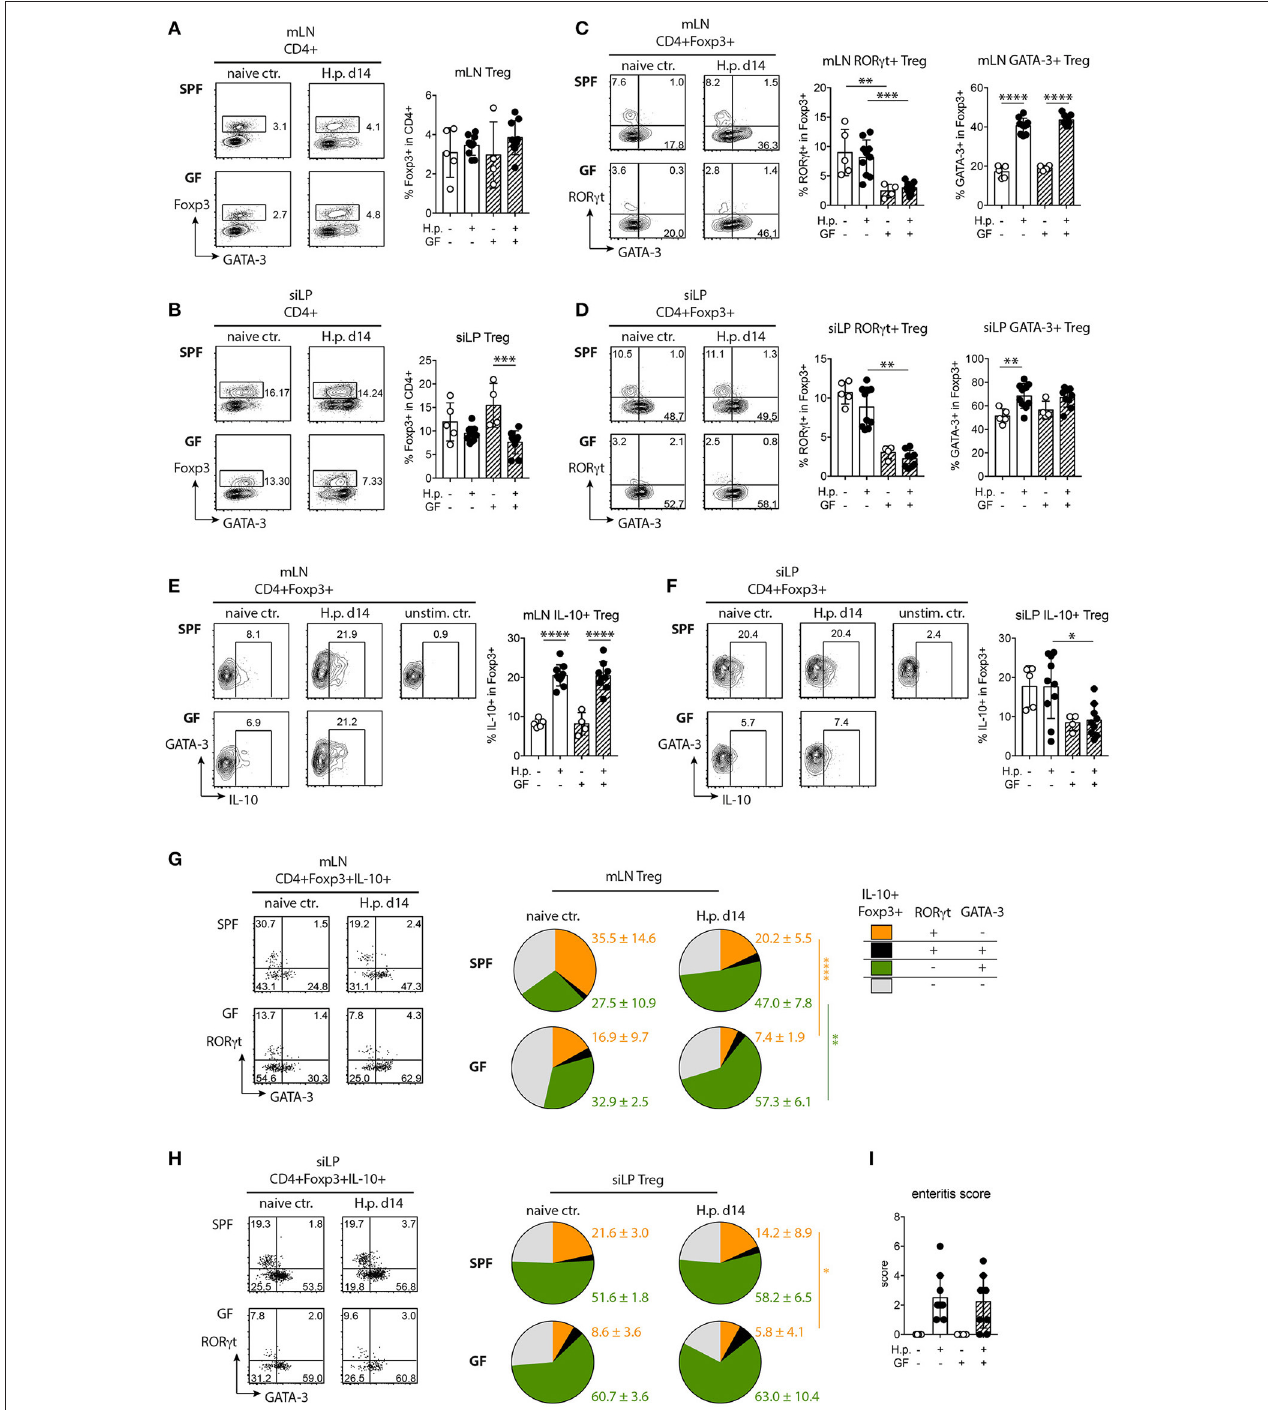
FIGURE 4 | Treg responses in SPF and GF mice infected with H. polygyrus . (A,B) Representative plots of Foxp3 + Treg detection in CD4 + T cells and Treg frequencies in mesenteric lymph nodes (mLN, A ) and small intestinal lamina propria (siLP, B ) of uninfected controls and mice infected with H. polygyrus for 2 weeks. (C,D) Representative plots of ROR γ t and GATA-3 expression by Treg and frequencies of ROR γ t + and GATA-3 + Treg in mLN (C) and siLP (D) . (E,F) Representative plots of IL-10 expression and frequencies of IL-10 + Treg in mLN (E) and siLP (F) . (G,H) Representation of ROR γ t + , ROR γ t + GATA-3 + , GATA-3 + , and ROR γ t − GATA-3 − Treg in the IL-10 + Treg population in mLN and siLP of naïve and infected mice. Numbers express group means and SD. (I) Duodenal enteritis scores. Data are pooled from two independent experiments each performed with two to three uninfected and four to five infected mice per group. Mean, SD, and individual data points are shown in (A–H) . * p < 0.05; ** p < 0.01, *** p < 0.001, **** p < 0.0001.